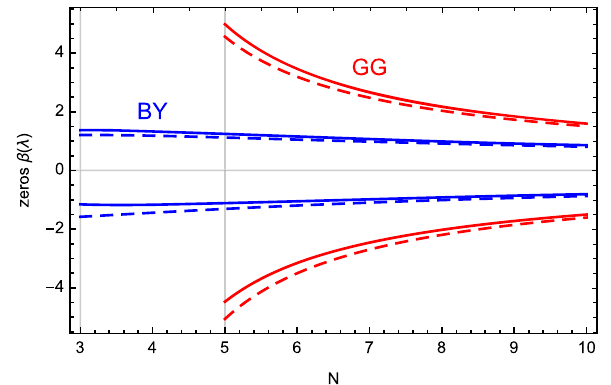
Fig. 4 Zeros of β(λ) as a function of N for BY (blue) and GG (red) models. The solid lines correspond to y = y UV = 0, while the dashed ones correspond to y = y IR . The numerical values correspond to n g = 10 N ; however, other choices can be easily inferred knowing that the zeros scale behaves as λ ∗ ∼ n − 1